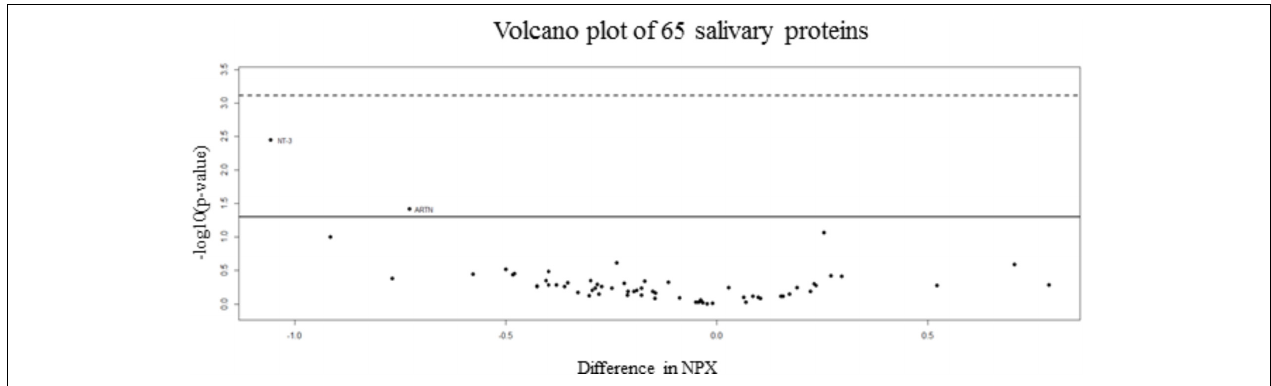
FIGURE 1 | Volcano plot of salivary inflammatory proteins. The volcano plot visualizes the p -value ( y -axis) and difference in NPX ( x -axis) for all 65 analyzed proteins. Proteins on the positive x -axis have higher NPX-values in the non-concussed group and proteins on the negative x -axis have higher NPX-values in the concussed group. The solid line indicates an unadjusted p -value of 0.05 and the dashed line indicates approximated adjusted p-value (FDR) of 0.05.